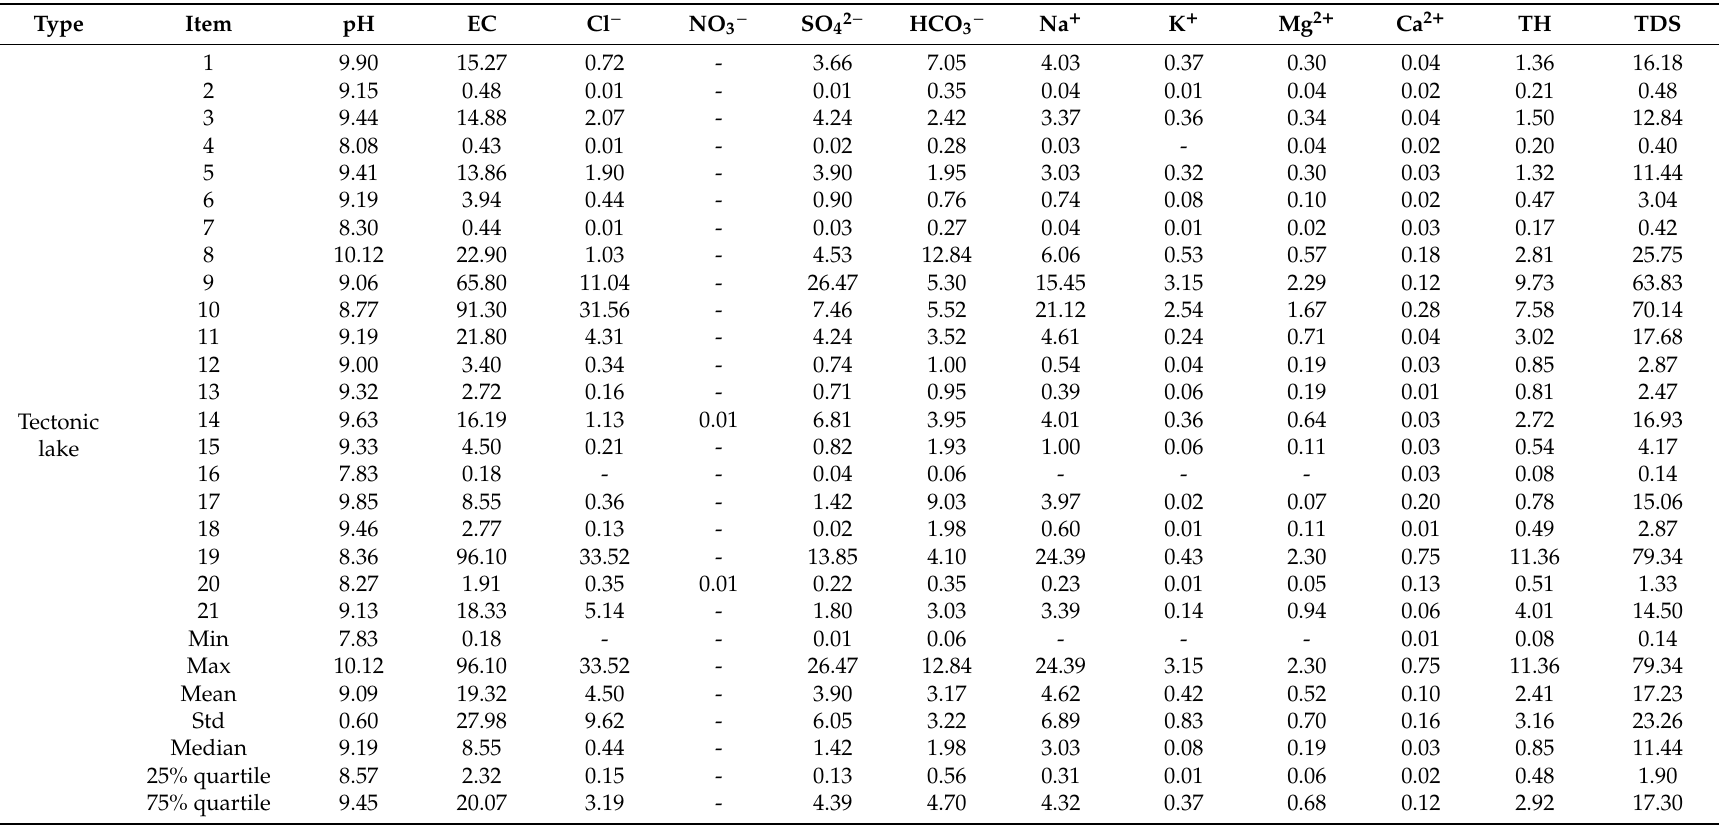
Table 2. The physicochemical indexes and major ion concentration of tectonic lakes and glacial lakes in Tibetan Plateau.